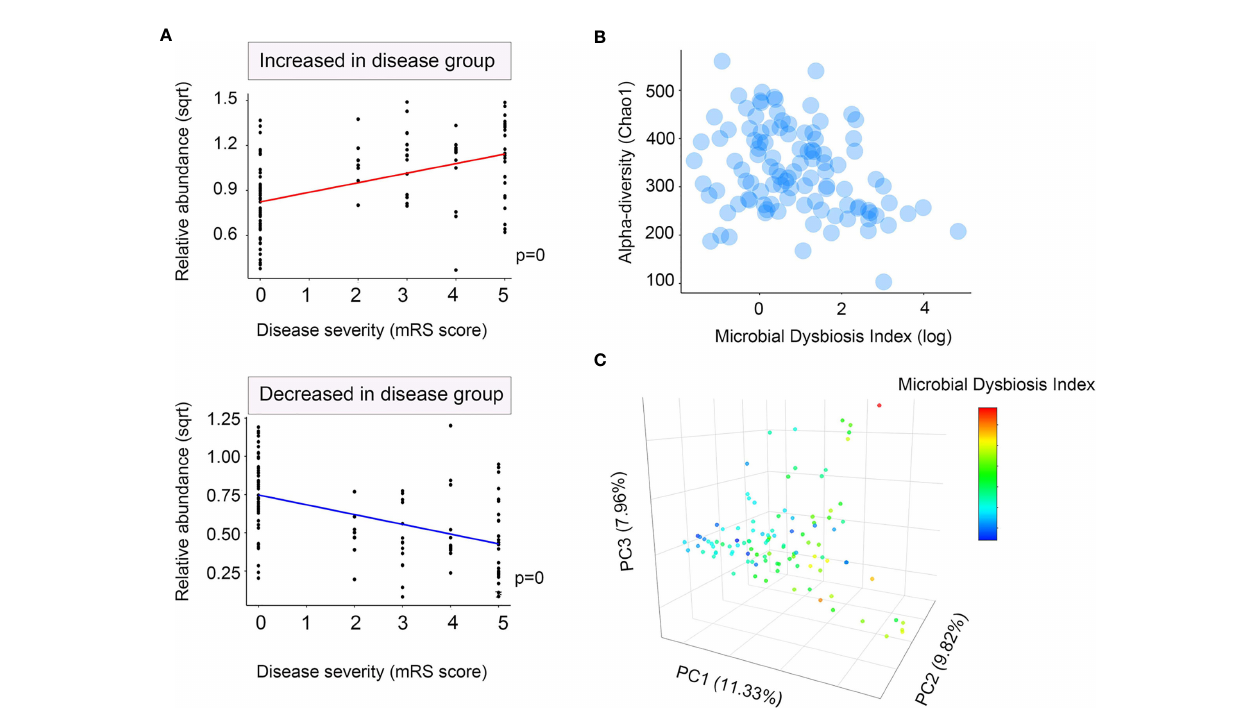
FIGURE 3 | Microbial dysbiosis index (MD-index) characterizing anti- N -methyl- D -aspartate receptor (NMDAR) encephalitis severity. (A) Scatter plot of arcsine square root transmuted abundance for all summed abundances for the taxa decreased ( bottom ) or increased ( top ) in patients with NMDAR encephalitis versus the modi fi ed Rankin scale (mRS) score as a disease severity measure. (B) Scatter density plot for species richness vs. the MD-index for each sample. In samples with a high MD- index, a strong reduction in the species richness was observed. (C) Principal coordinate plot for unweighted UniFrac distance, colored using the MD-index. It can be noticed that the three principal coordinates strati fi ed the samples by MD-index, which exhibited negative correlations with species richness. Sqrt , square